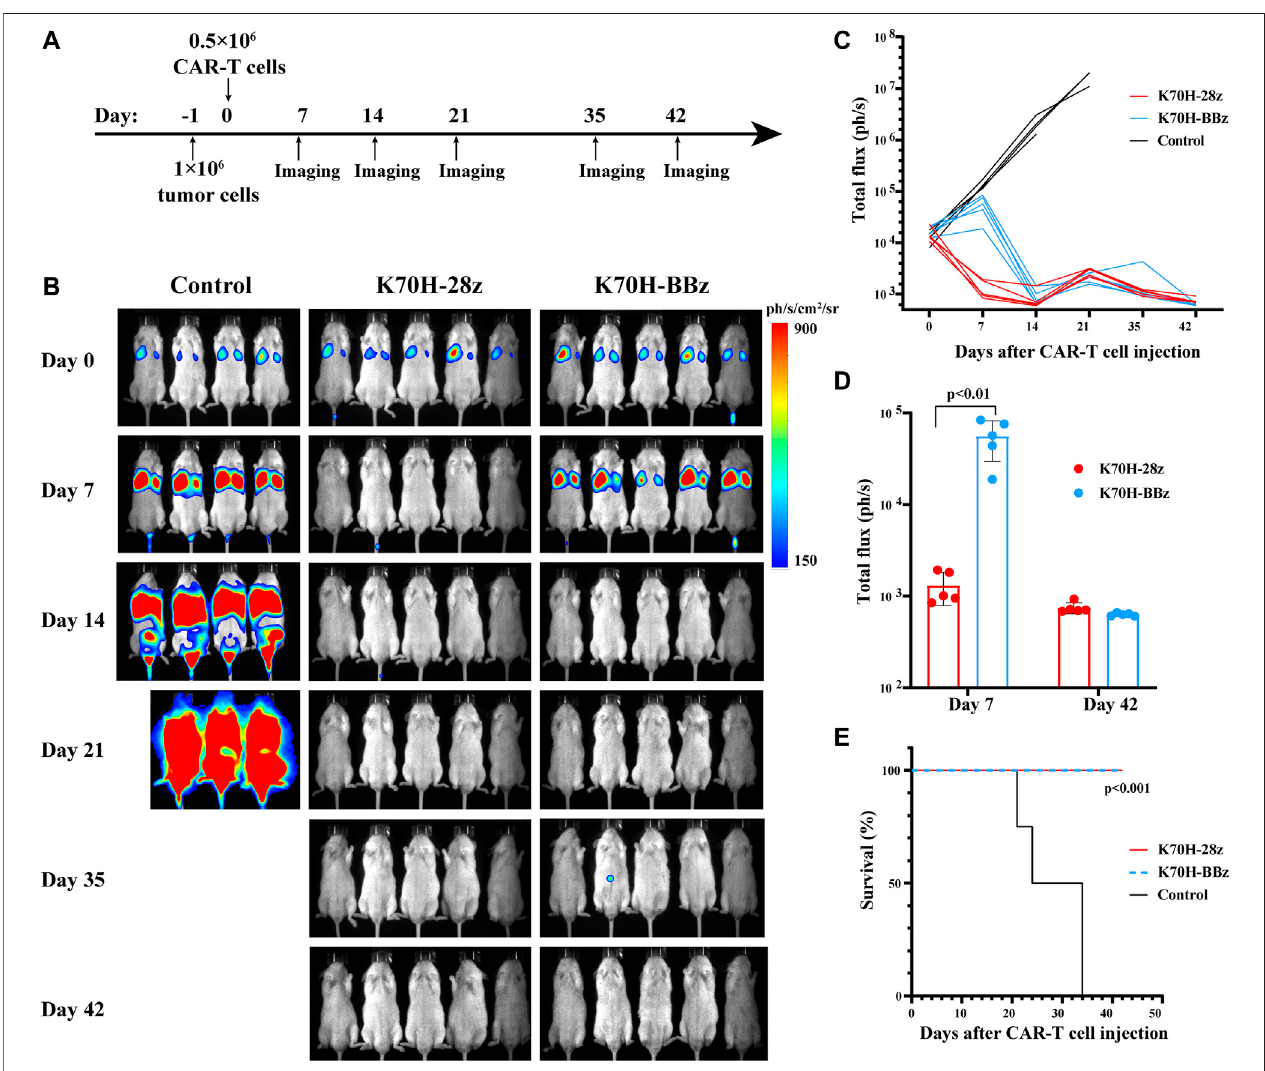
FIGURE5| In vivo anti-tumorfunctionsofTSHR CAR-T cells. (A) Schematictimelineofthe invivo experimental design. NSG micewereintravenouslyinjected with 1×10 6 8505c-TSHR cells. The next day, they were treated with 0.5 × 10 6 K70H-28z CAR-T cells ( n = 5), K70H-BBz CAR-T cells ( n = 5) or PBS ( n = 4). (B) Bioluminescence imaging of mice at indicated days after treatment. (C) Quanti fi cation of tumor burden of mice. (D) Tumor burden of K70H-28z CAR and K70H-BBz CAR-T groups at day 7 and 42. Error bars: mean ± SD. (E) Kaplan-Meier analysis of survival of mice from different groups.